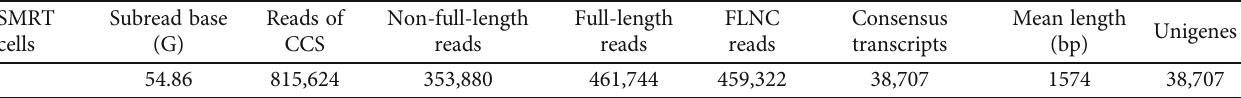
Table 1: Representation of Iso-Seq from the sepal of Lilium davidii var. unicolor Salisb by PacBio Sequel system.